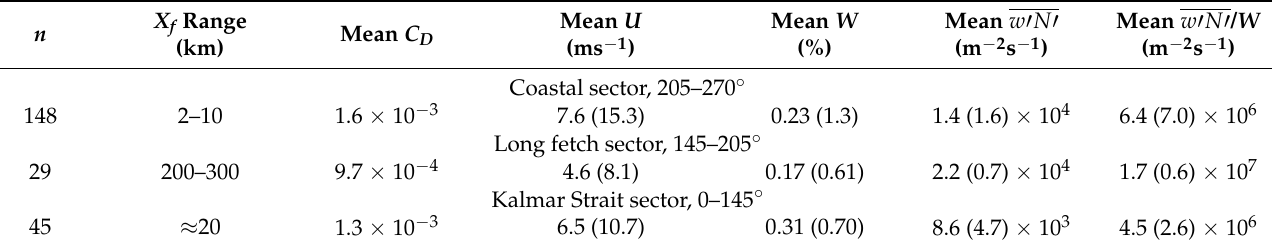
Figure 3. ( a ) Fetch (red curve with red diamonds) as a function of wind direction, the distance from the Garpen lighthouse to the nearest coast. Distance to sea depths of 3 m (full blue curve), 6 m (dashed blue curve), 10 m (dashed-dotted blue curve), and 20 m (blue dotted curve). ( b ) Like ( a ) but for the mean wind speed. ( c ) Like ( b ) but for the drag coefficient. ( d ) Like ( b ) but for the white cap coverage according to Equation (6), open sea (large grey circle), and according to Equation (7), limited fetch (red crosses). ( e ) Like ( d ) but for the upward dry aerosol number flux (large grey circles) and the upward non-volatile aerosol number flux (red crosses). ( f ) Like ( e ) but with the aerosol fluxes normalized with white cap coverage according to Equation (6). Table 1. Summary of conditions characterizing each wind